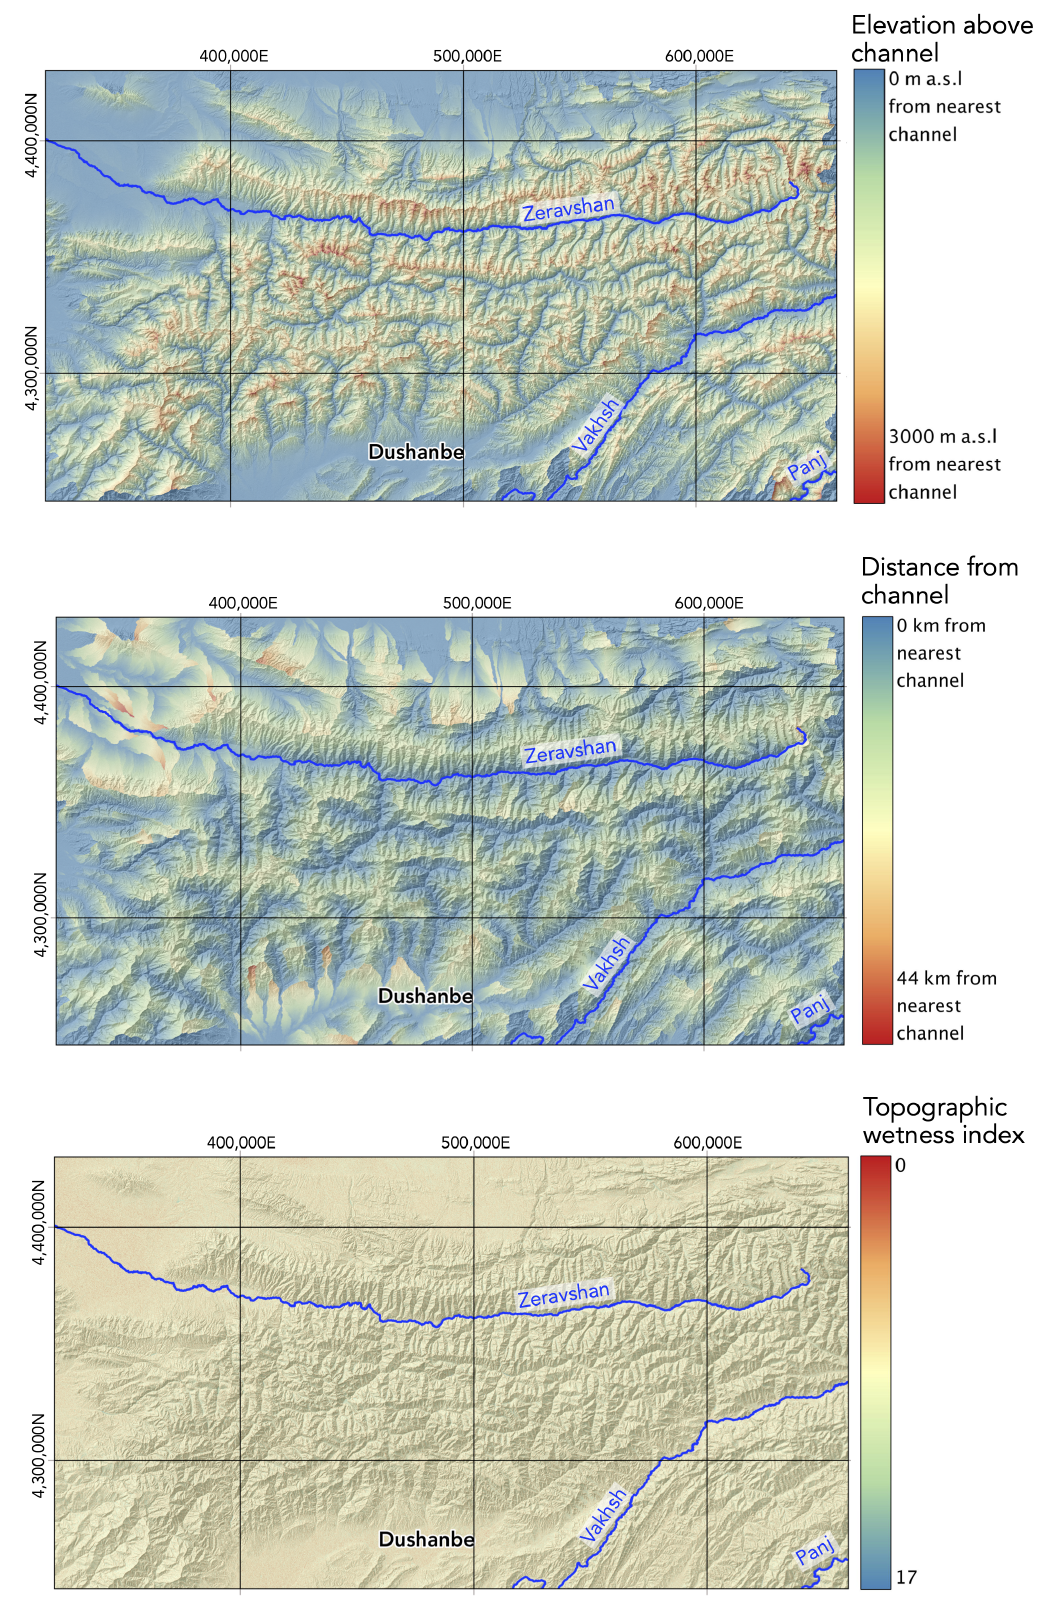
Figure A4. Hydrological